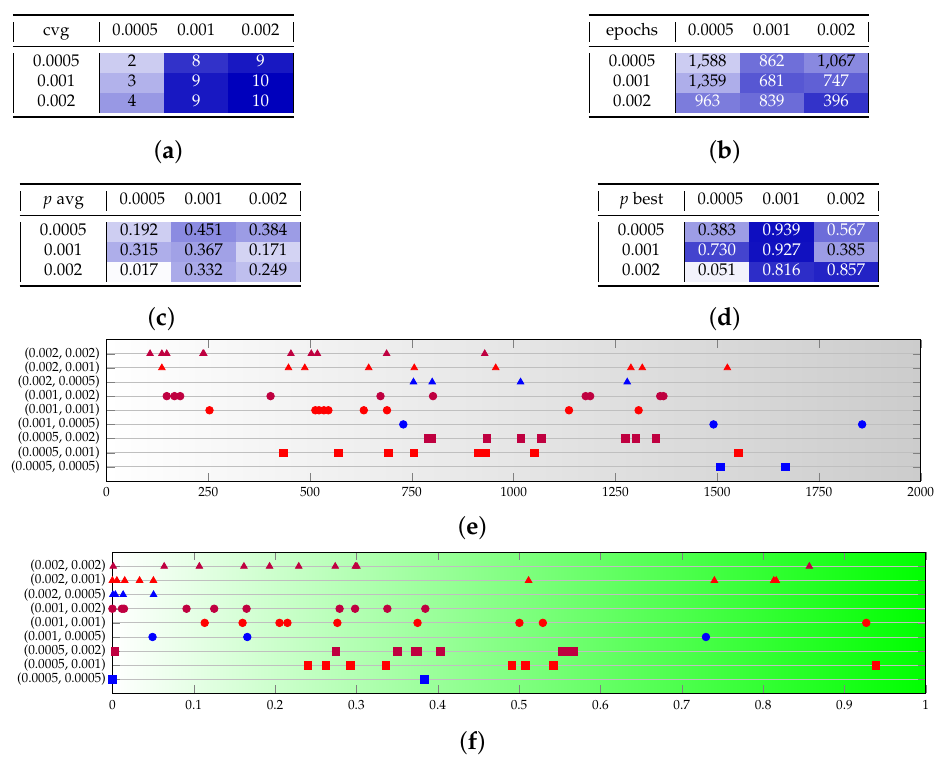
(a) Converging runs, out of 10. (b) Number of epochs before convergence, on average. (b) Number of epochs before convergence, on average.